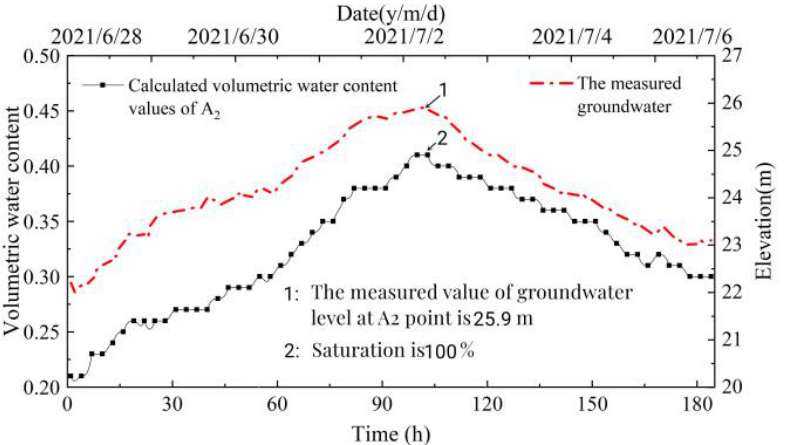
Figure 13. The volumetric water content and measured groundwater at point A 2 during the flood process.